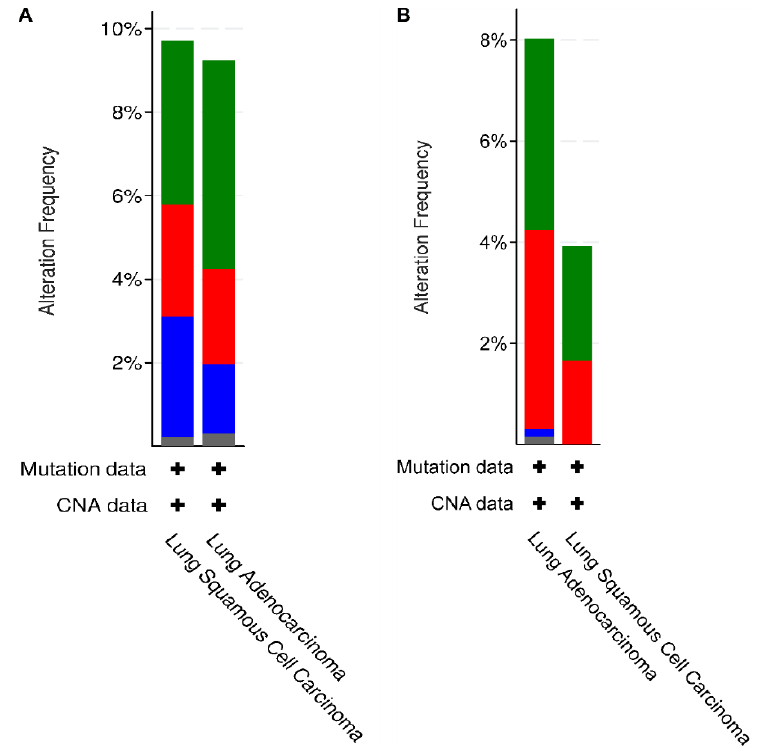
Figure 6. ( A ) Barplot showing the alteration frequency of all hub genes (9.24% of 660 cases of LUAD and 9.71% of 484 cases of LUSC) across TCGA Pan-NSCLC dataset. Green bars represent frequency of mutations (5% in LUAD and 3.93% in LUSC), red bars represent frequency of amplifications (2.27% in LUAD and 2.69% in LUSC), blue bars represent frequency of deep deletion (1.67% in LUAD and 2.89% in LUSC), and grey bars represent frequency of multiple alterations (0.3% in LUAD and 0.2% in LUSC). ( B ) Boxplot showing alteration frequency of 2 TFs—HMGA2 and E2F7—with overall frequency of 6% (8.04% of 660 cases of LUAD and 3.93% of 484 cases of LUSC) in the selected NSCLC dataset. Green bars represent frequency of mutations (3.79% in LUAD and 2.27% in LUSC), red bars represent frequency of amplifications (3.94% in LUAD and 1.65% in LUSC), blue bars represent frequency of deep deletion (0.15% in LUAD), and grey bars represent frequency of multiple alterations (0.15% in LUAD).